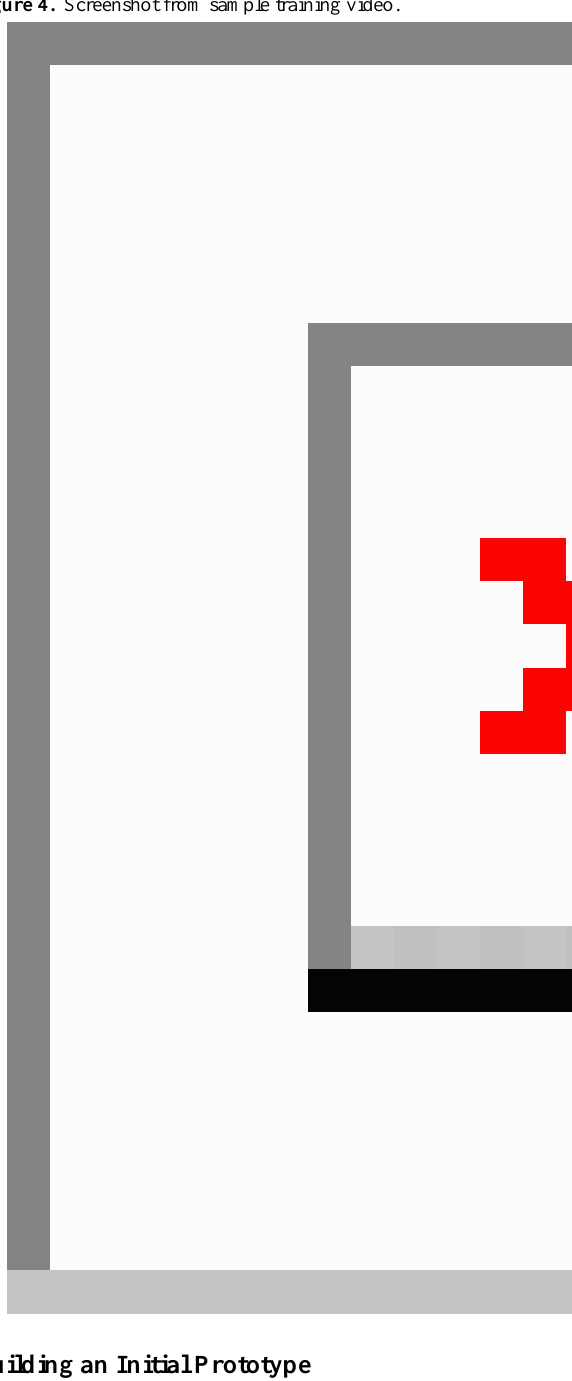
Figure 4. Screenshot from sample training